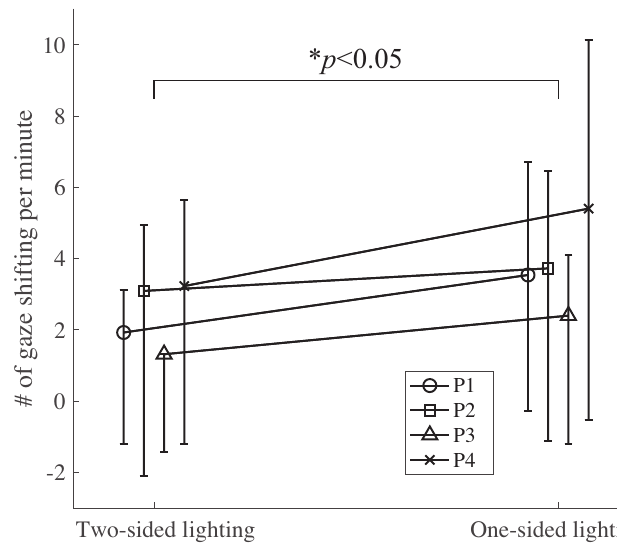
Figure 7. Average and range of the number of gaze-shifting per minute counted by three coders (C1, C2 and C3).